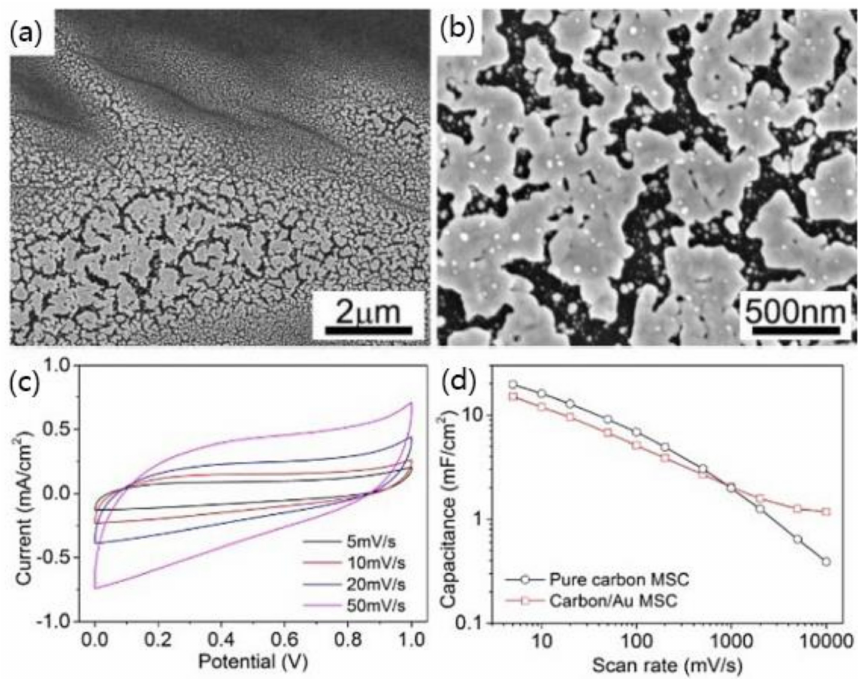
Figure 16. ( a , b ) The SEM images of carbon/Au composite electrode; and ( c ) CV curves of carbon/Au MSC; ( d ) Comparison of surface capacitance of pure carbon MSC and carbon/ Au MSC